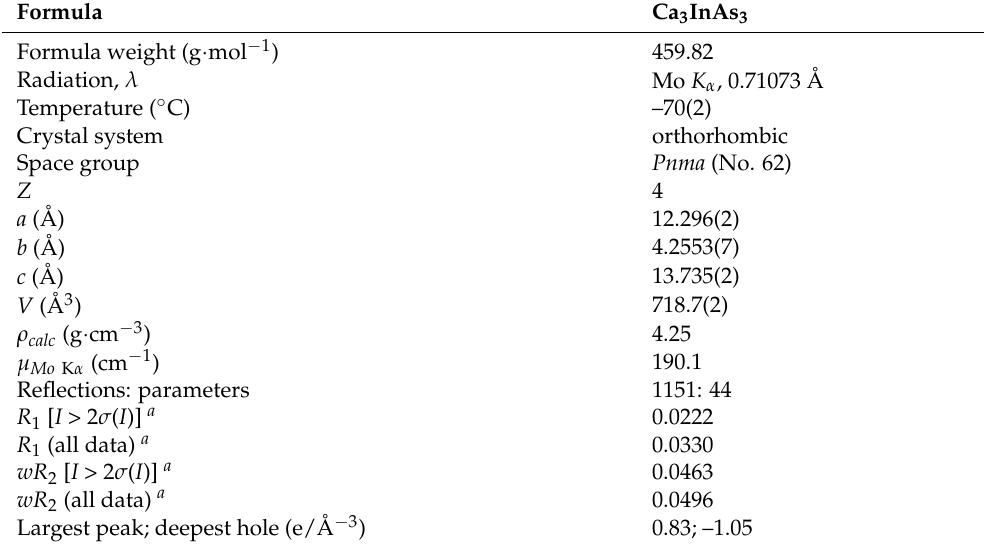
Table 1. Selected crystal data and structure refinement parameters for Ca 3 InAs 3 .